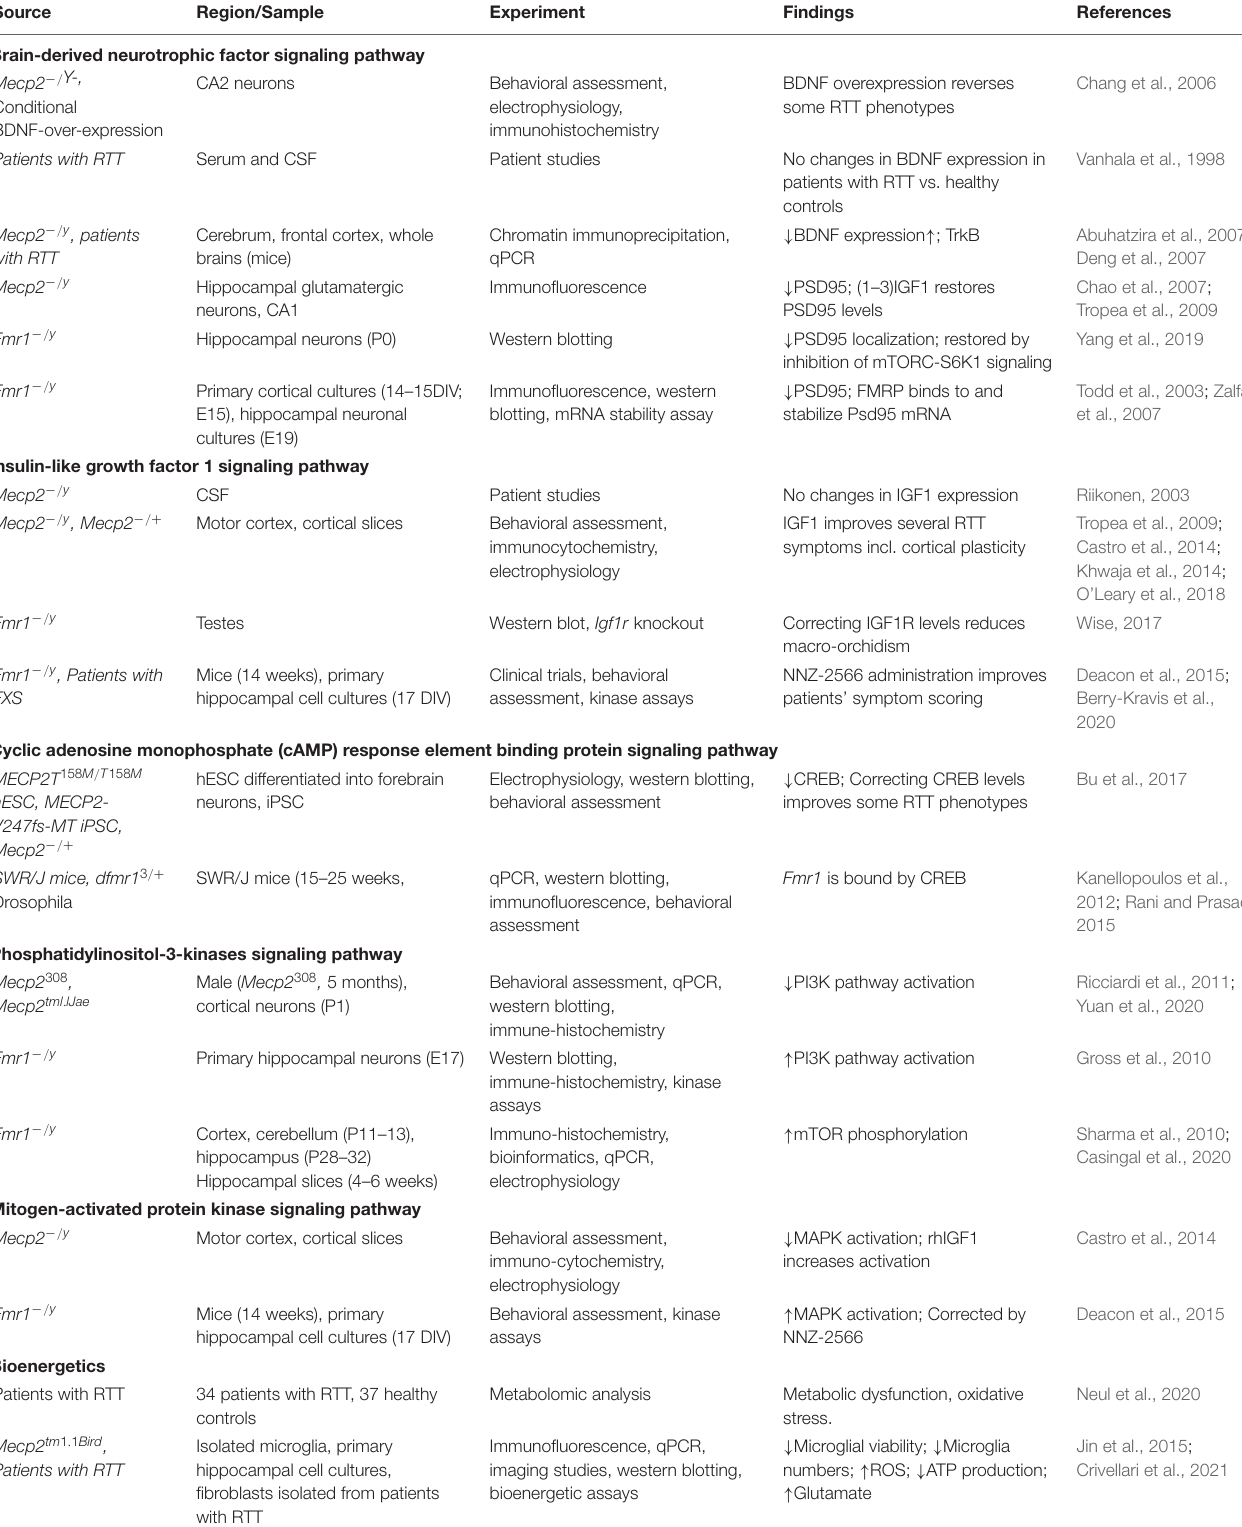
TABLE 5 | Pathways implicated in Rett syndrome and Fragile X